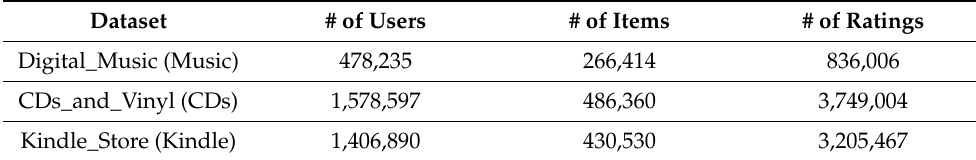
Table 2. # of users, items and ratings of the datasets.